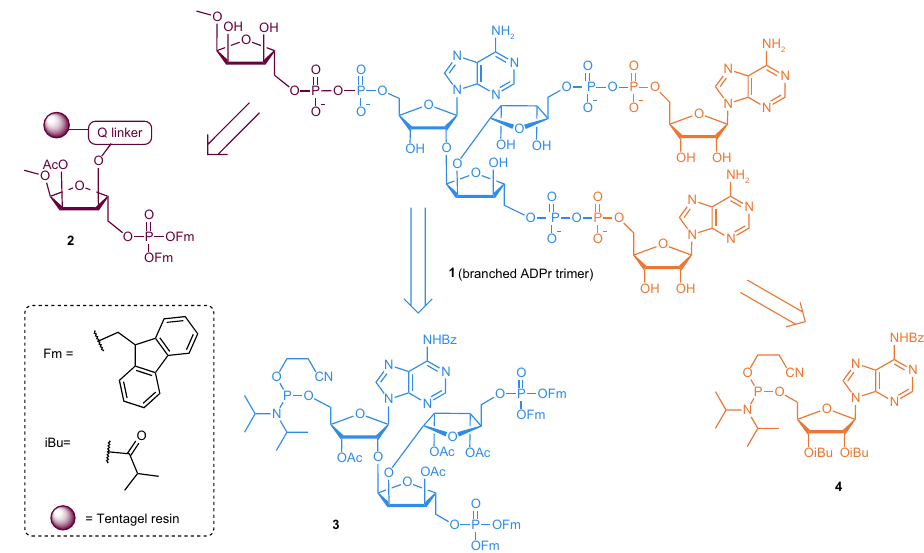
Fig. 1 Retrosynthetic analysis for branched ADPr-trimer (1). ADPr-trimer 1 with substructures originating from the three distinct building blocks: ribofuranoside 2 immobilized on TentaGel (purple), phosphoramidite of branch point 3 (blue) and adenosine phosphoramidite 4 (orange). The dotted box shows the chemical structure of Fm ( fl uorenylmethyl group) and i Bu (isobutyryl group). Purple sphere represents TentaGel resin. Bz benzoyl, Ac acetyl, Q-linker hydroquinone- O , O ′ -diacetyl.